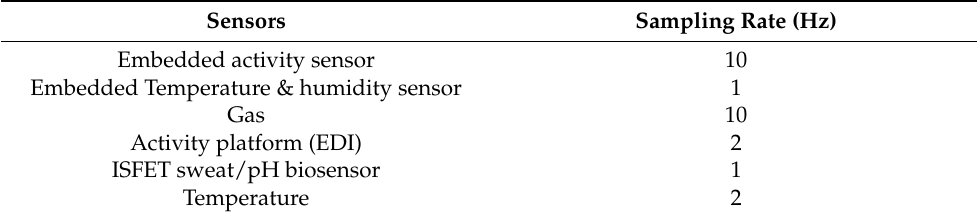
Table 1. Sampling rate of the different sensors.